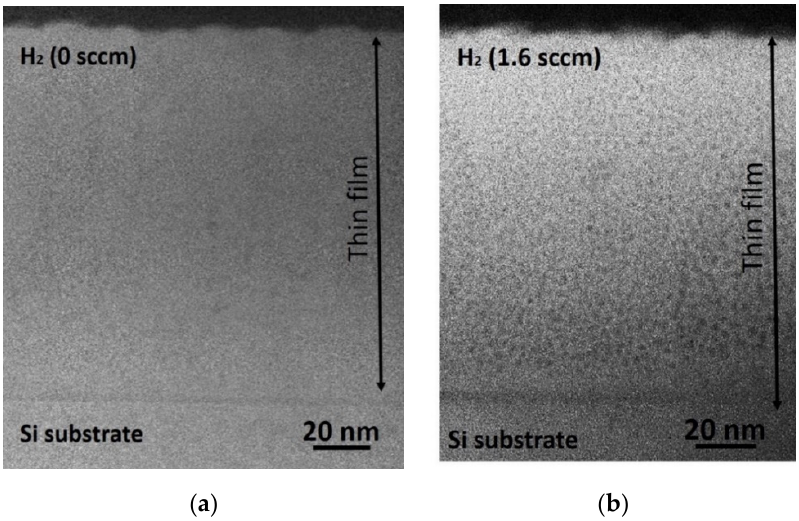
Figure 7. High-angle annular dark-field (HAADF) STEM images of a-SiN x thin films: ( a ) hydrogen-free a-SiN x thin film (S1), ( b ) a-SiN x :H (S3).